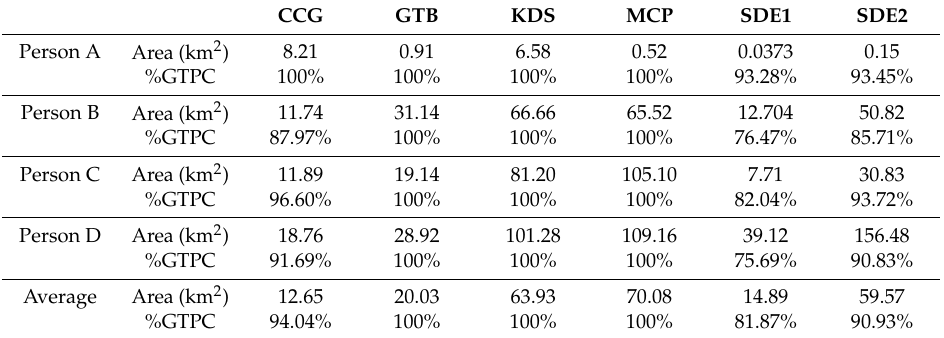
Table 4. Comparing the representative participants’ activity spaces generated by different